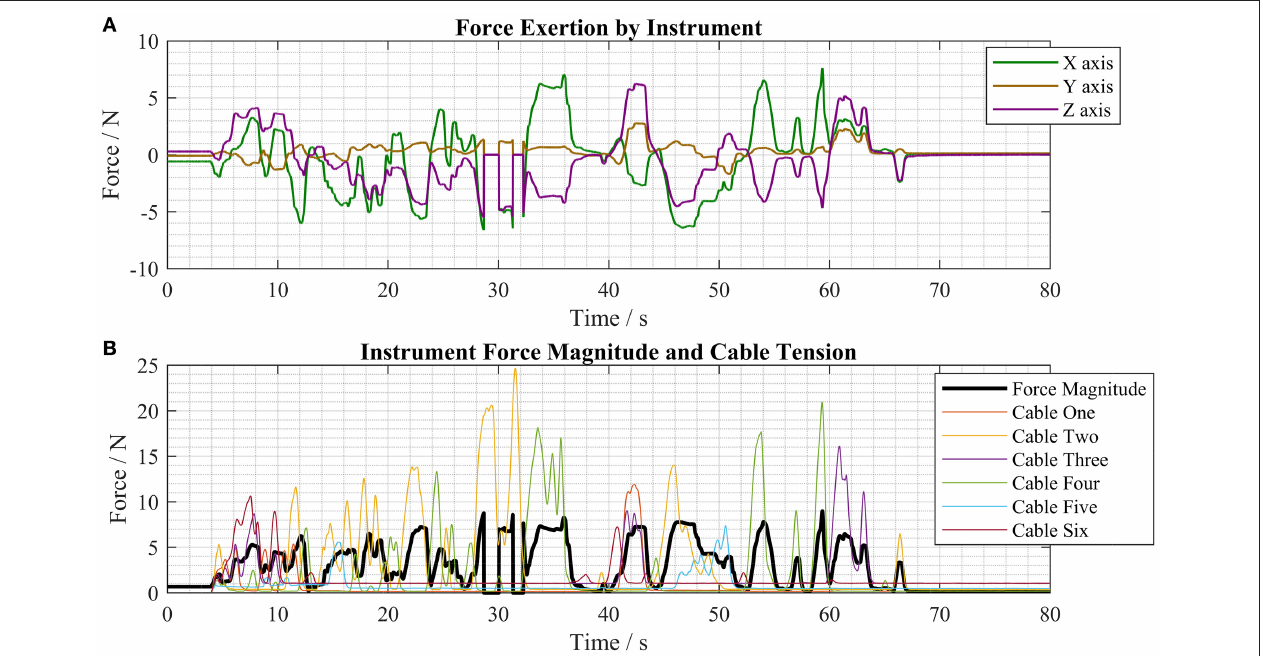
FIGURE 9 | Force measurements taken during typical motions of the master controller (A) force exertion by the instrument in the X, Y, and Z axes (B) force magnitude and cable tension forces during the same test period.